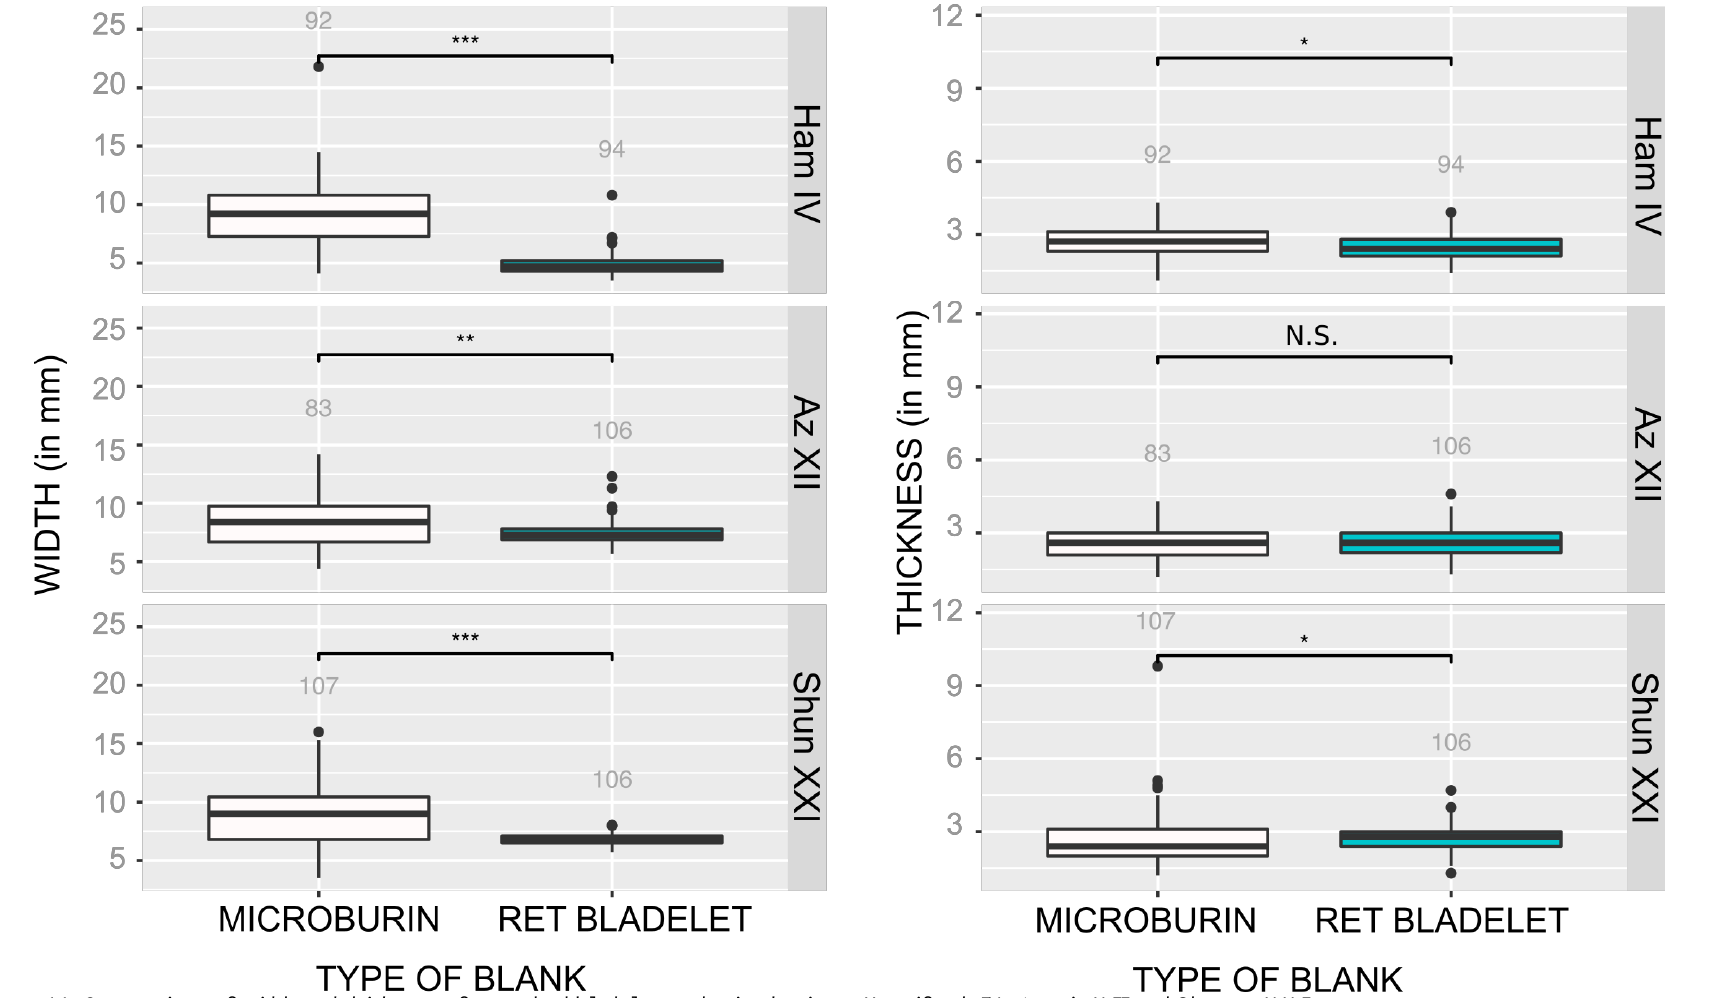
Figure 11. Comparison of width and thickness of retouched bladelets and microburins at Hamifgash IV, Azariq XII and Shunera